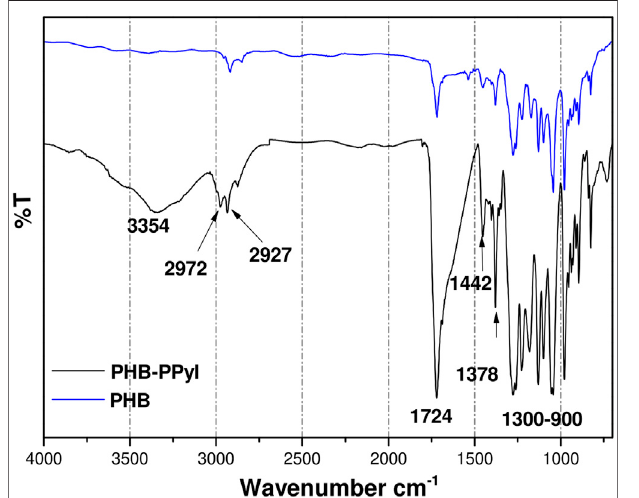
FIGURE 4 | X-ray diffractograms of PHB and PHB-PPyI. The lattice parametersofPHBandPHB-PPyIscaffoldwerea (cid:2) 5.65 Å,b (cid:2) 13.61 Åandc (cid:2) 5.86